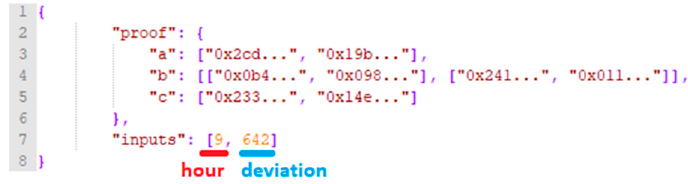
Figure 7. Snippet for energy deviation registration.